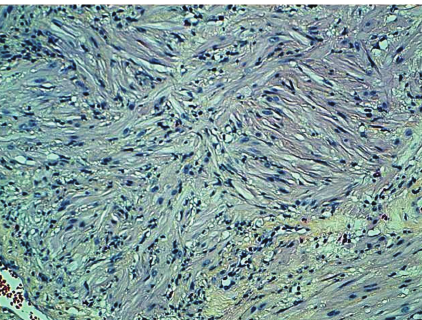
Figure 2: Spindle cells of smooth muscle with abundant cytoplasm and without nuclear atypia or mitosis (HES ×